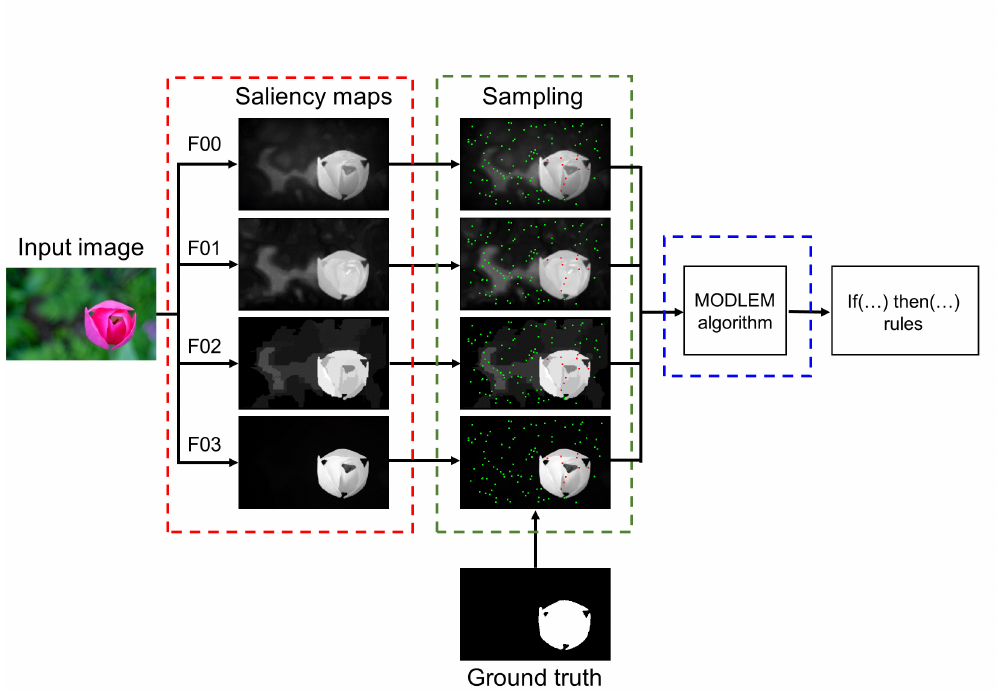
Figure 2. Illustration of the training stage. Firstly, saliency maps are computed. Secondly, sampling is carried out by using labeled annotations from ground truth. Then, the learning step is performed by the MODLEM algorithm and the result is a rule-based saliency detection